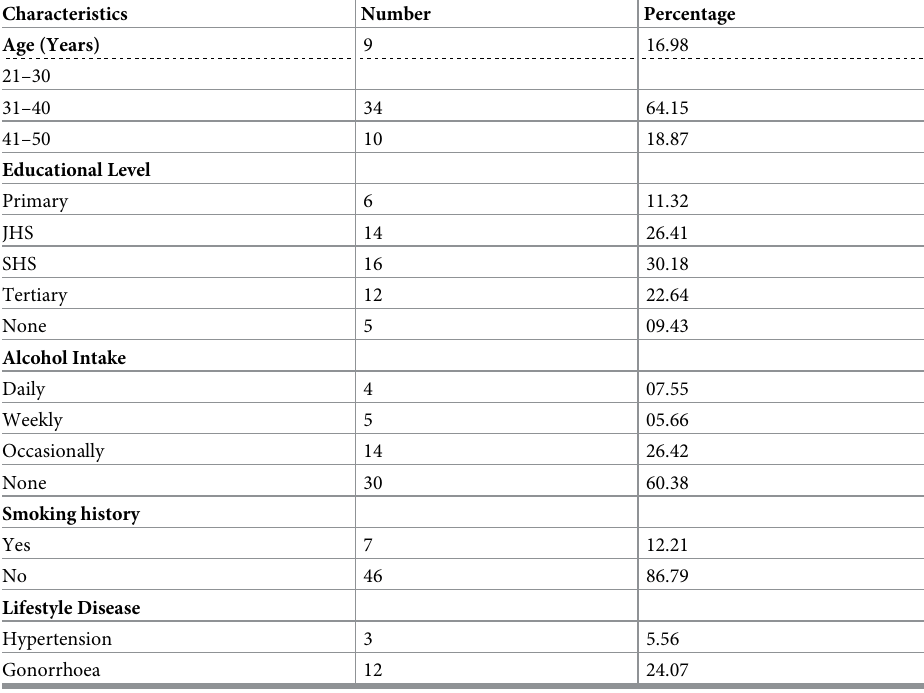
Table 1. Demographics, lifestyle and clinical history of the study